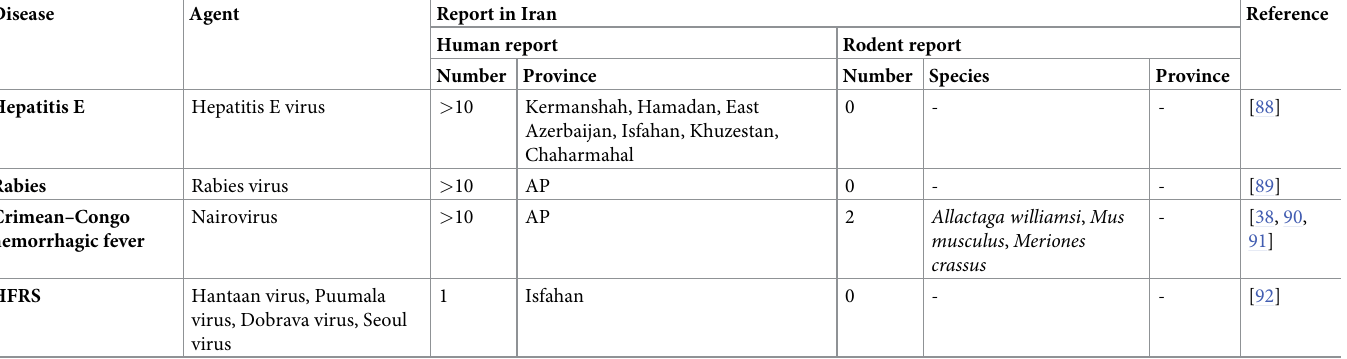
Table 2. Viral rodent-borne diseases reported in Iran.